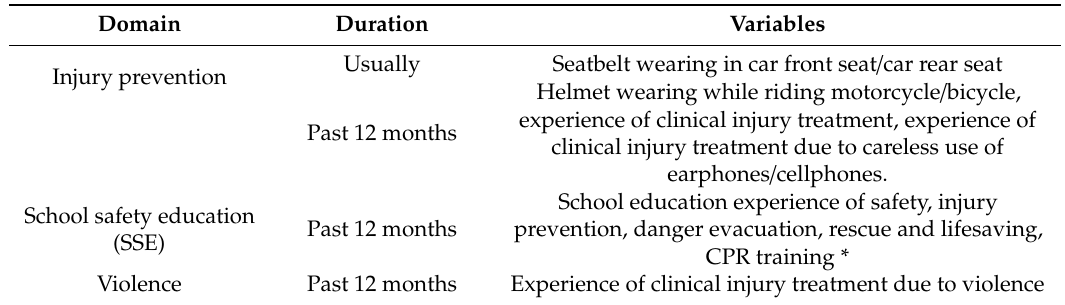
Table 1. Variables for injury prevention, school safety education, and violence related to tooth fracture experience from the 14th Korea Youth Risk Behavior Survey in